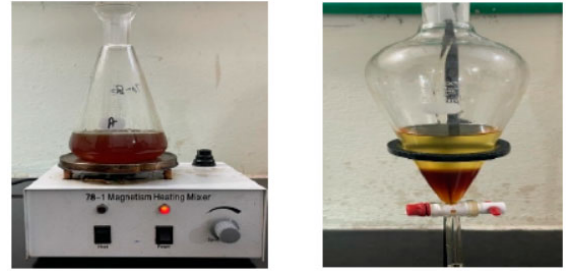
Figure 3. Transesterification of waste cooking oil.